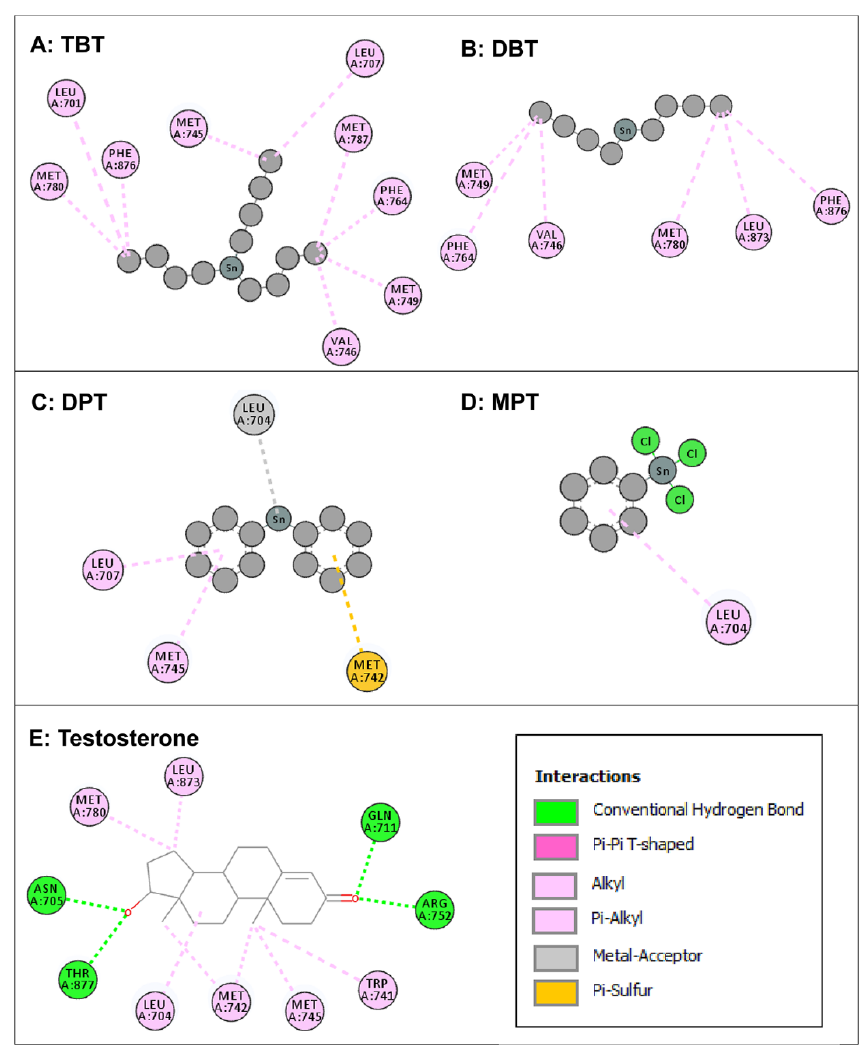
Figure 3. Two-dimensional interaction maps of amino acid residues of androgen receptor (AR) interacting with four organotin ligands during molecular docking in the ligand-binding site of AR. Amino acid residue interactions of the bound native ligand of AR (testosterone) are also shown. Tributyltin (TBT, Panel A ); dibutyltin (DBT, Panel B ); diphenyltin (DPT; Panel C ); monophenyltin (MPT, Panel D ); and testosterone (Panel E ). Amino acid residues with alkyl or pi-alkyl bonds are indicated in light pink color, an amino acid with pi-sulfur bond is indicated in yellow color, and an amino acid with a metal acceptor bond is indicated in grey color. Interactions box: the depicted colors for interaction legends apply to all five interaction maps in the figure.